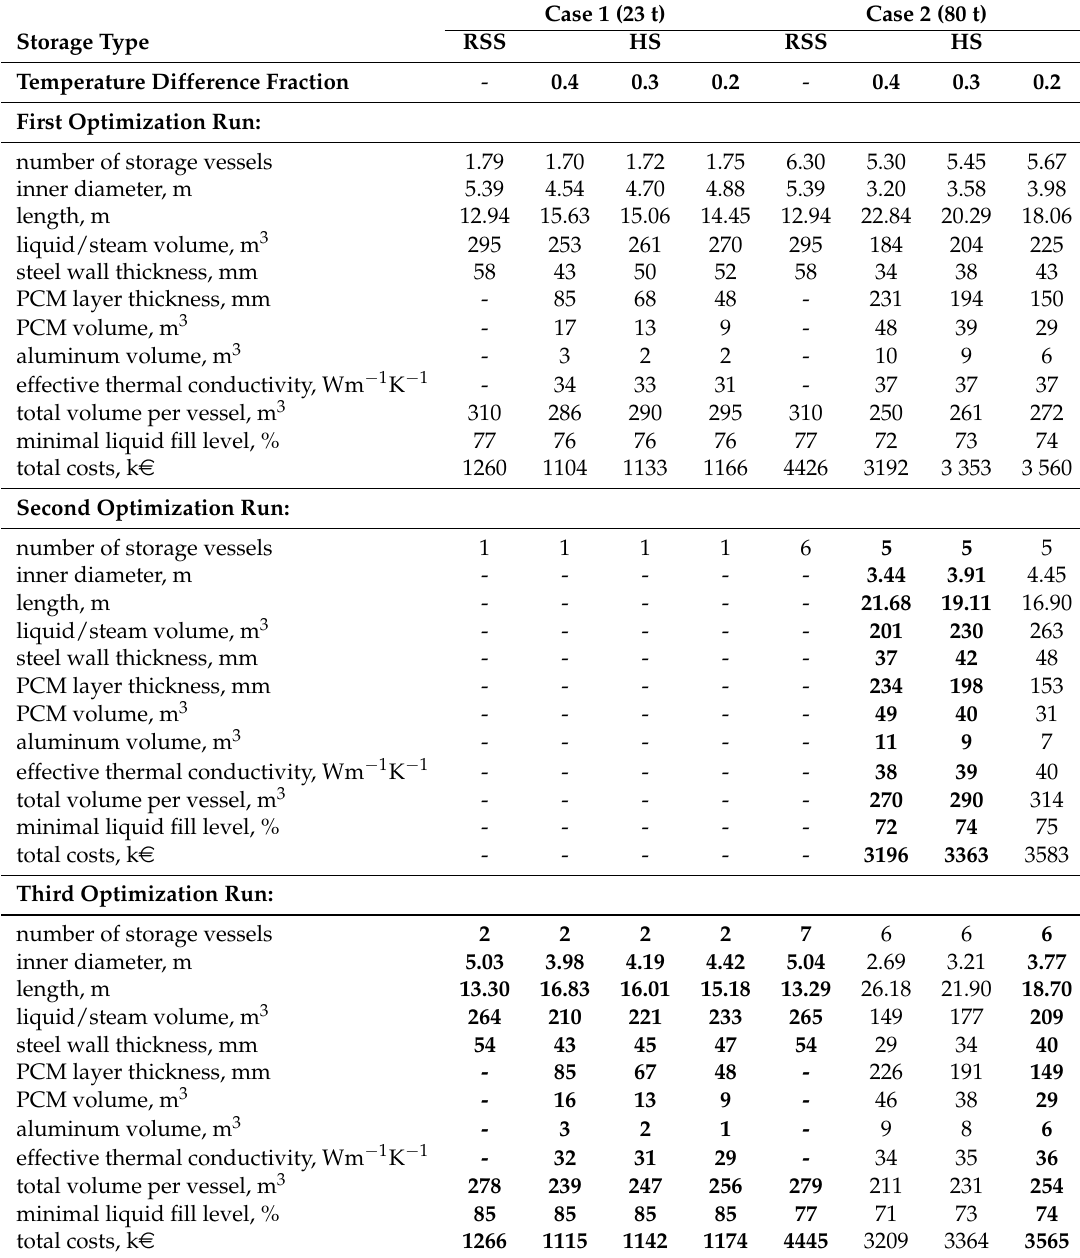
Table 7. Results of the storage design optimization (The results written in bold indicate the best results for integer values of the number of storage